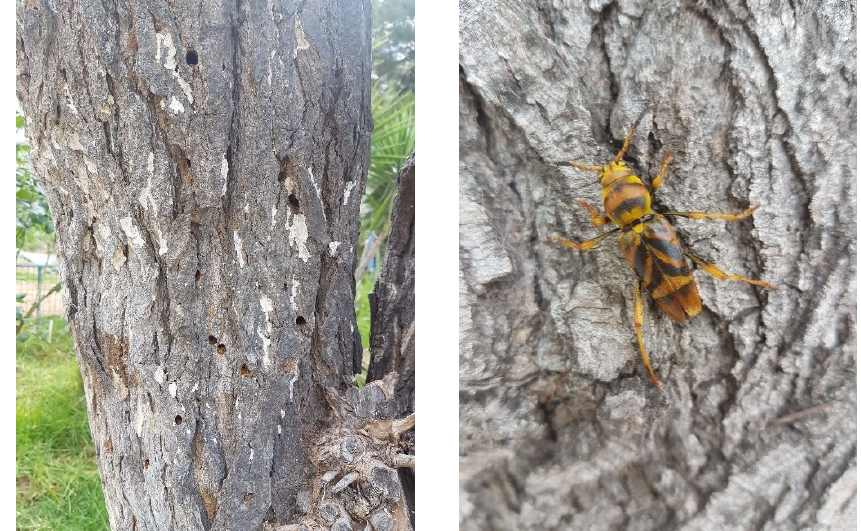
Figure 3. Left: exit tunnels of X. chinensis in a mulberry in Crete, Greece. Right: adult X. chinensis .